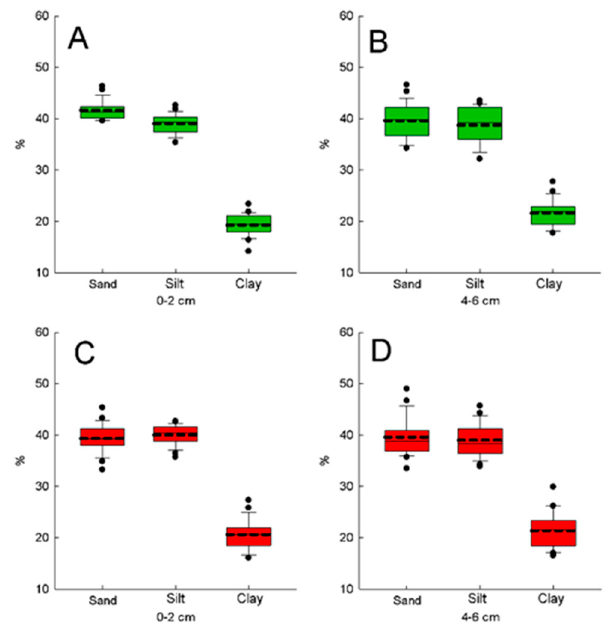
Figure 4. Soil grain size at 0–2 ( A , C ) and 4–6 ( B , D ) cm. Sand, silt and clay grain size (%) for the 25 plots under Tillage (red color) and 25 plots under No-Tillage (green color). Black dotted line: mean values; black thin line: median; points: outliers.